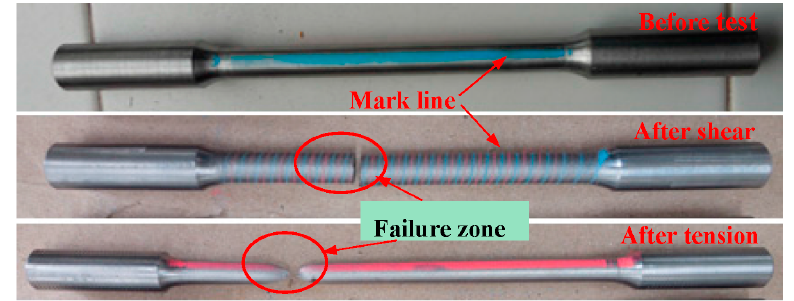
Figure 3. Images of the specimens before and after the tests.